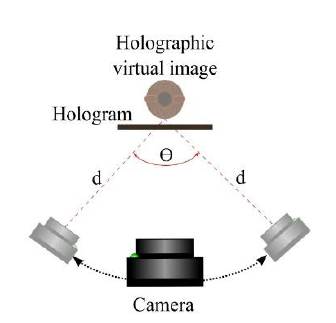
Figure 5. The setup of hologram digitization, top view.